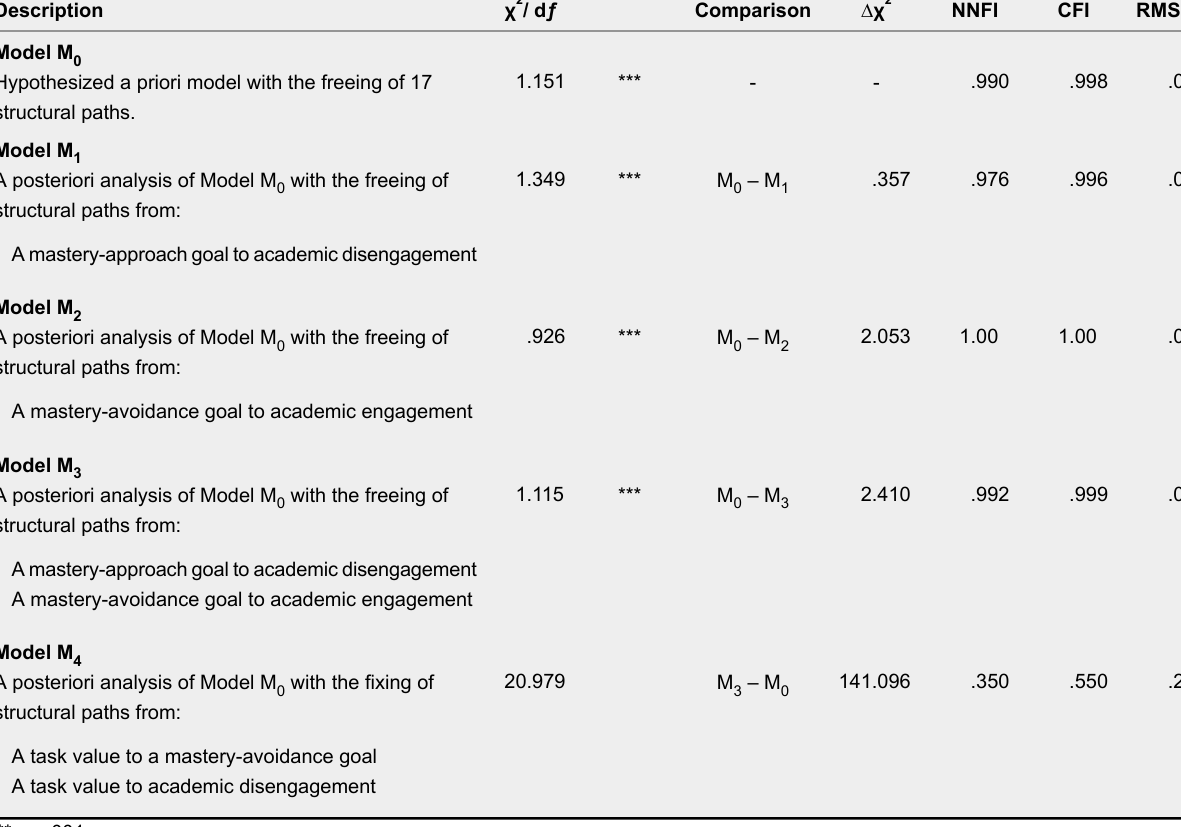
RMSEACFINNFI∆χ 2 Comparisonχ 2 / dƒDescription